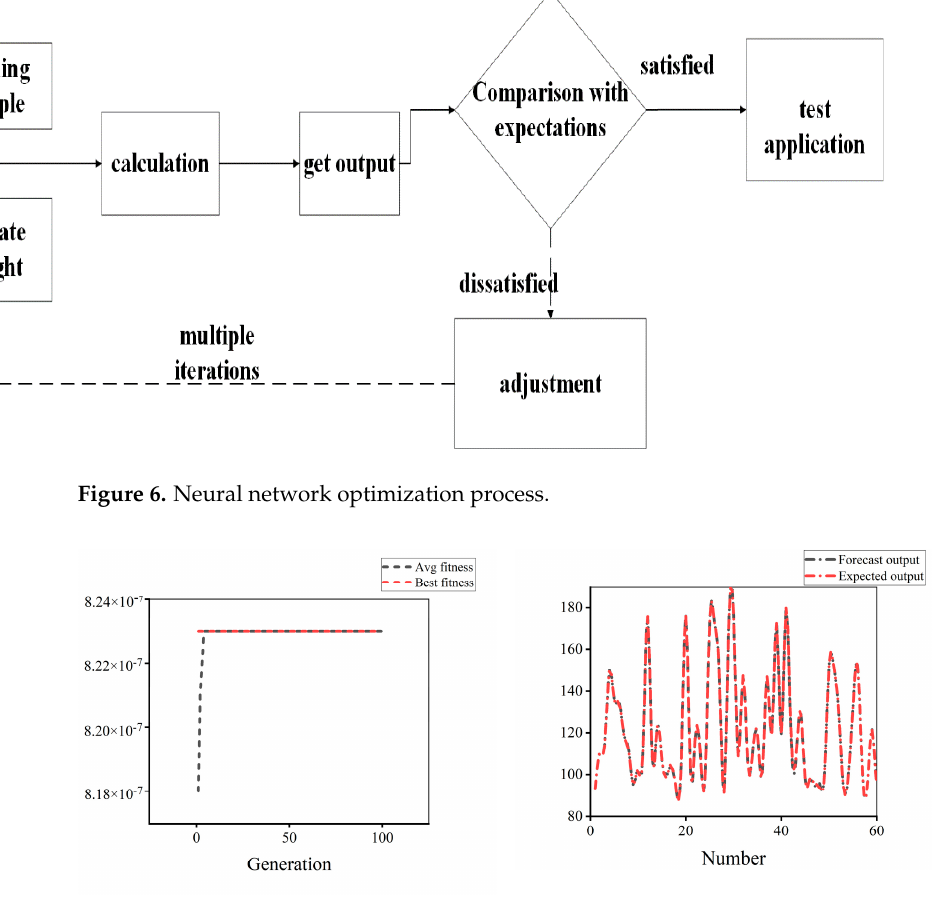
Figure 7. Neural network training graph: ( a ) F i tness variation diagram; ( b ) Test output error dia- gram.